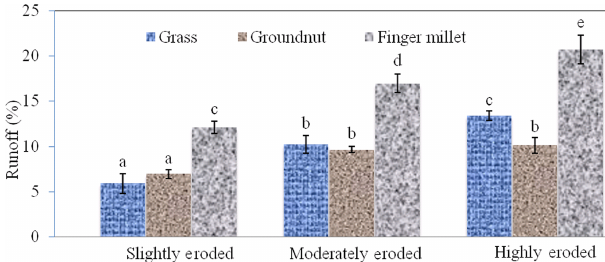
Figure 1. Complimentary role of grasses in enhancing soil profile moisture at 4 and 8% slope.